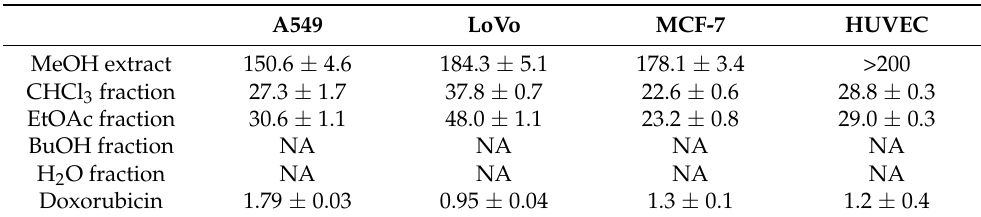
Table 1. IC 50 values in µ g/mL for E. saudiarabica fractions obtained by MTT assay with different cancer-cell lines, as well as normal HUVEC cells treated for 48 h.